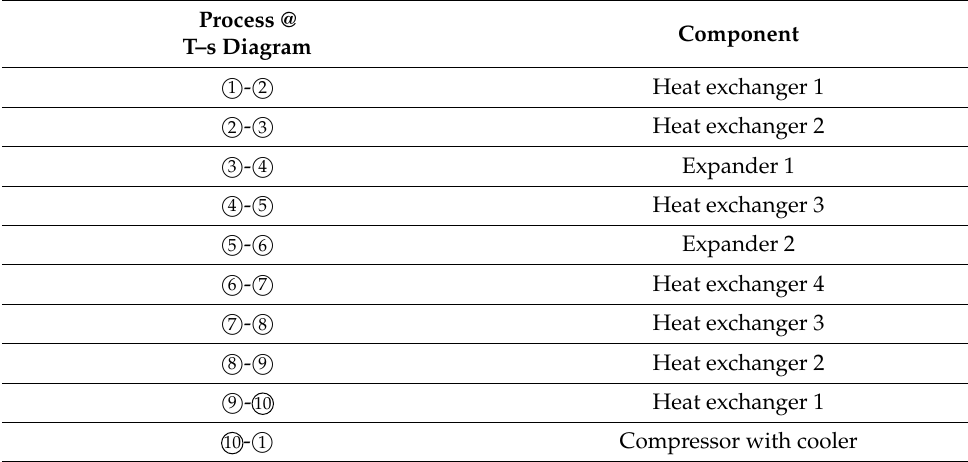
Figure 1. The 0.5-TPD class hydrogen liquefaction plant: ( a ) schematic of hydrogen liquefaction plant and ( b ) T – s diagram of hydrogen liquefaction plant. Table 1. Components involved in each process of the T – s diagram.